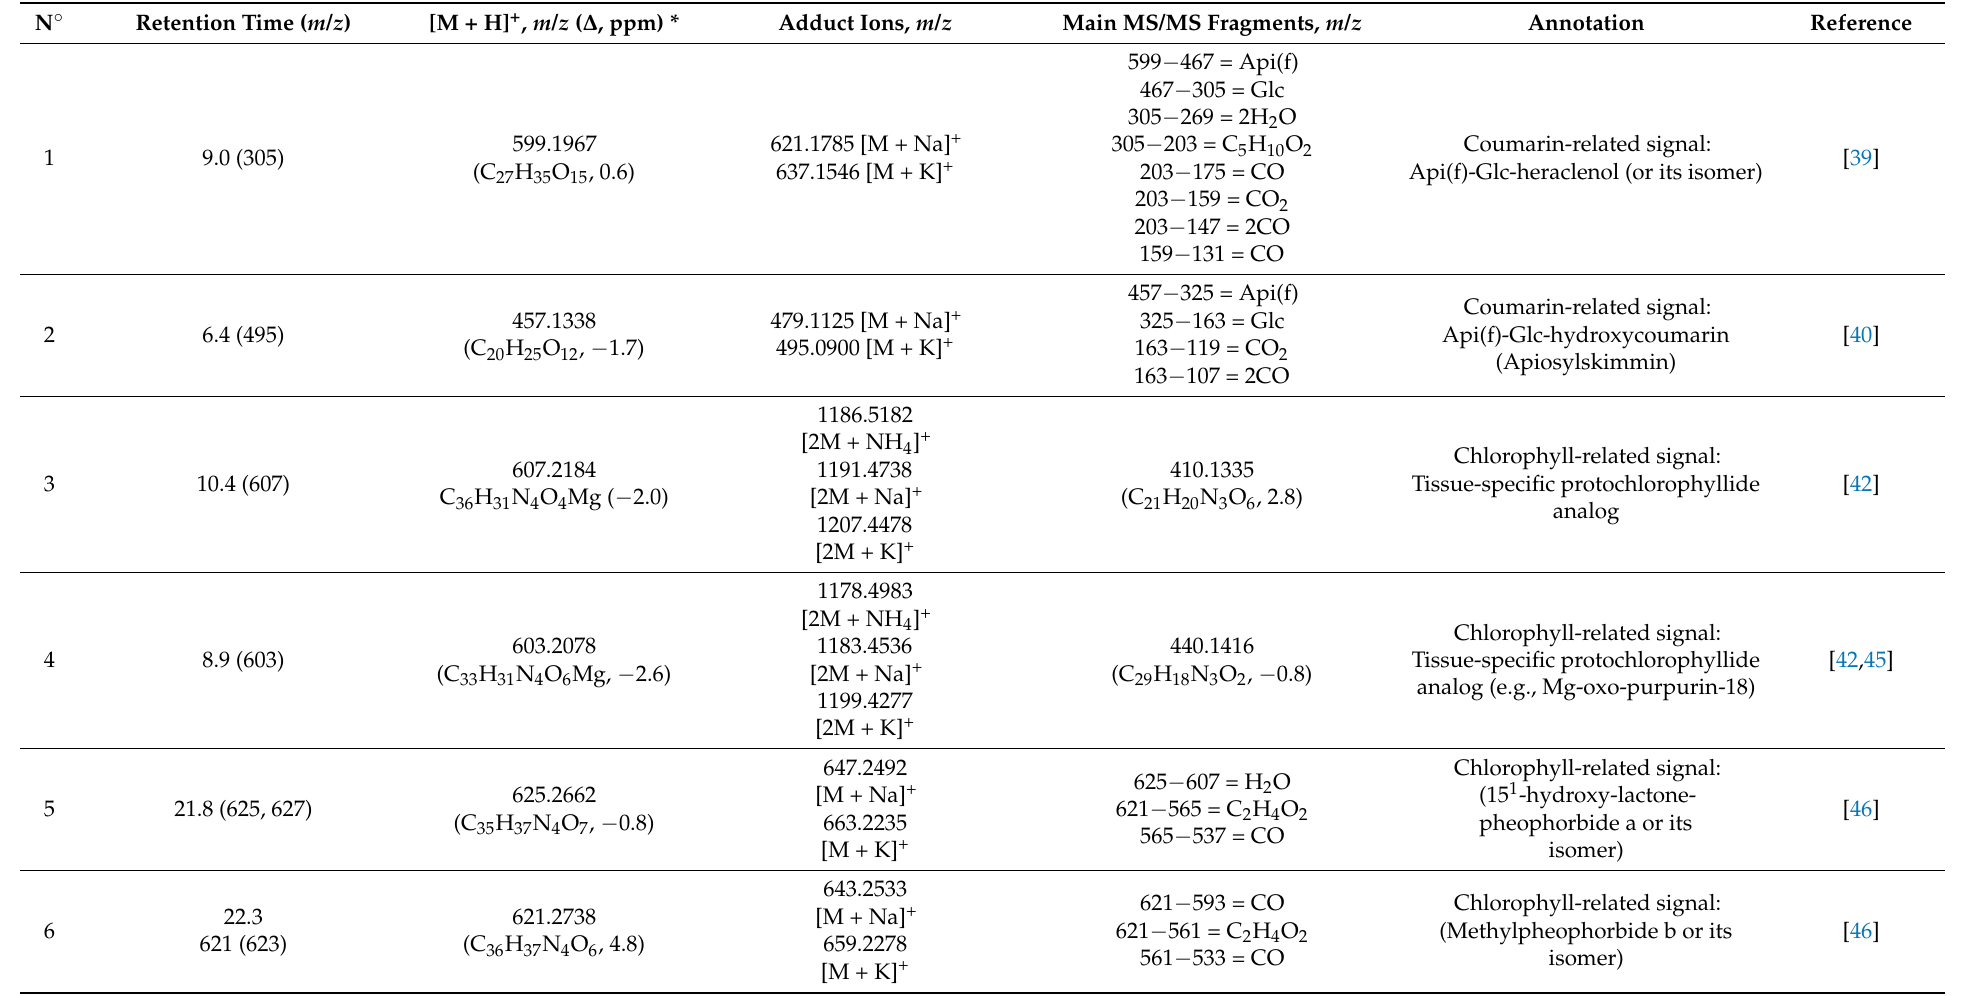
Table 4. Characteristic m / z features extracted by SVM and the preliminary identified